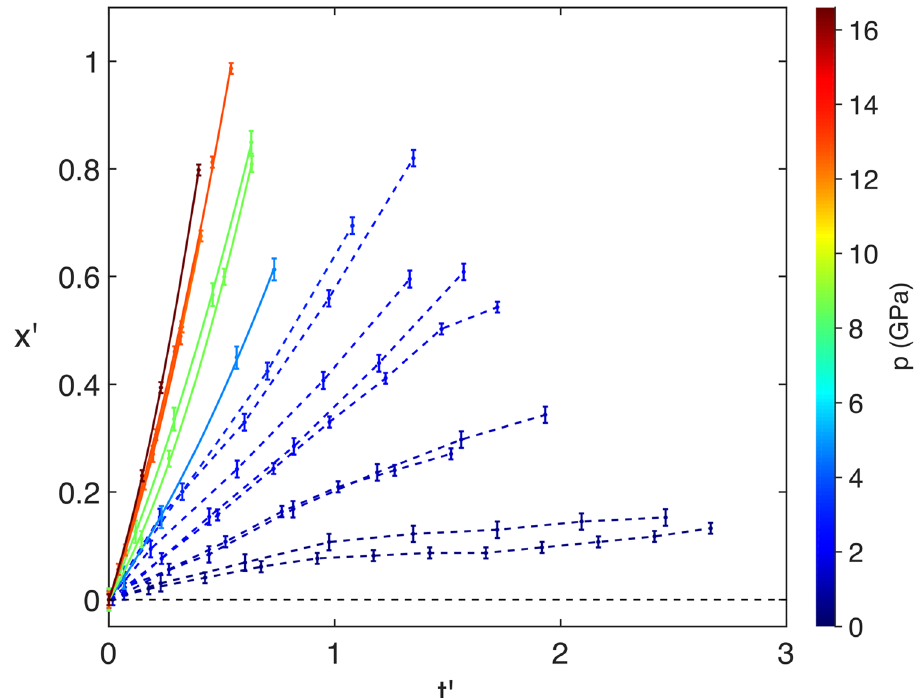
Figure 9. Plots of x ′ vs. t ′ . The solid lines show a quadratic fit for each interaction and a linear change in the initial shock pressure p is represented by the colour bar. The dashed lines show a piecewise linear interpolation of the low-pressure data.